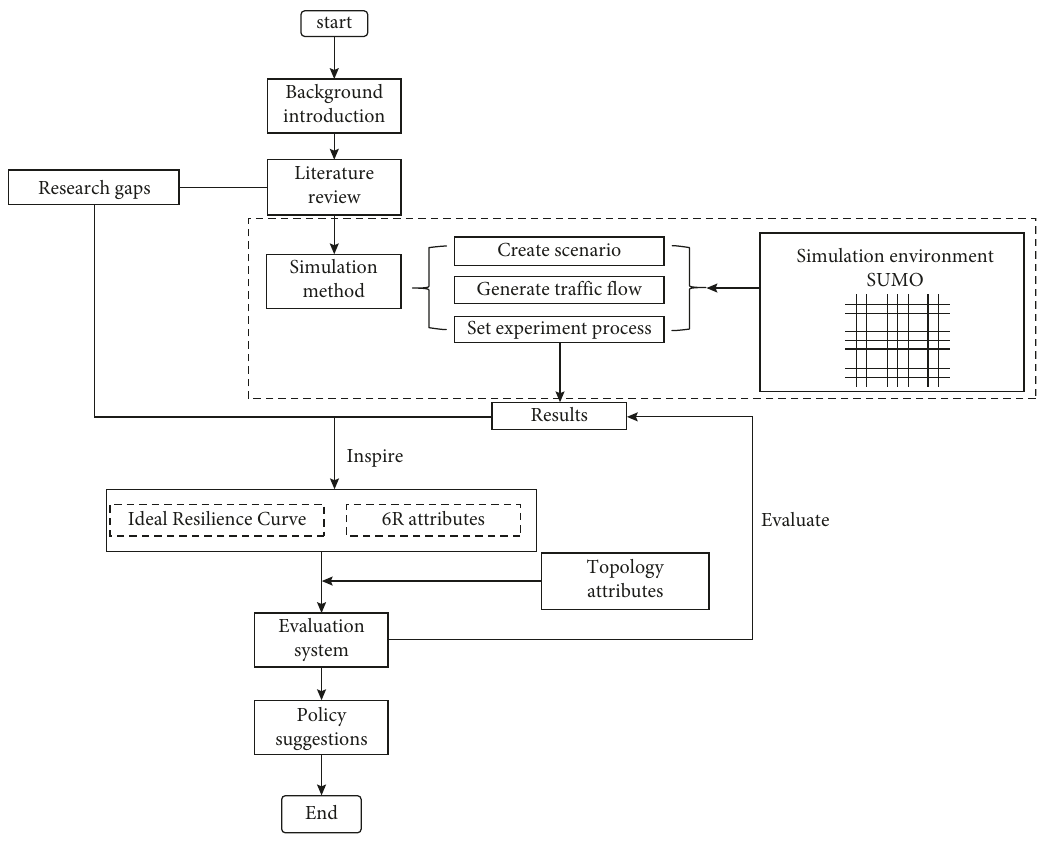
Figure 1: Structure of the